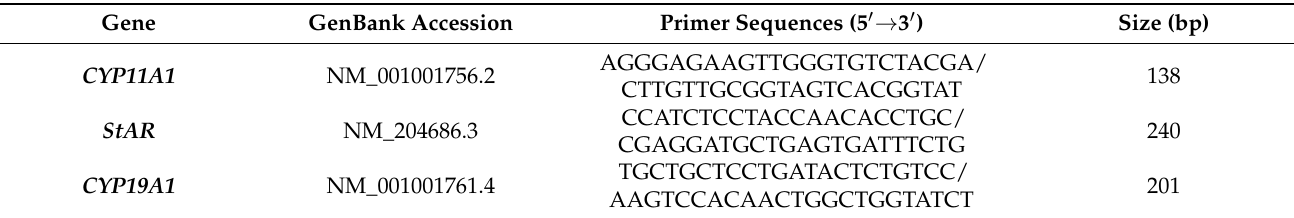
Table 2. Primer sequences for